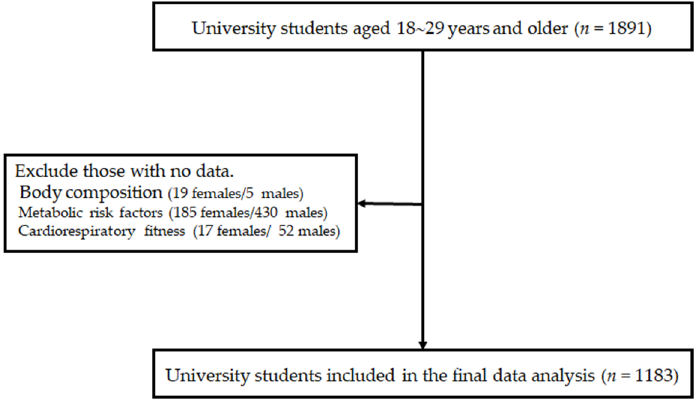
Figure 1. Flow of eligible study